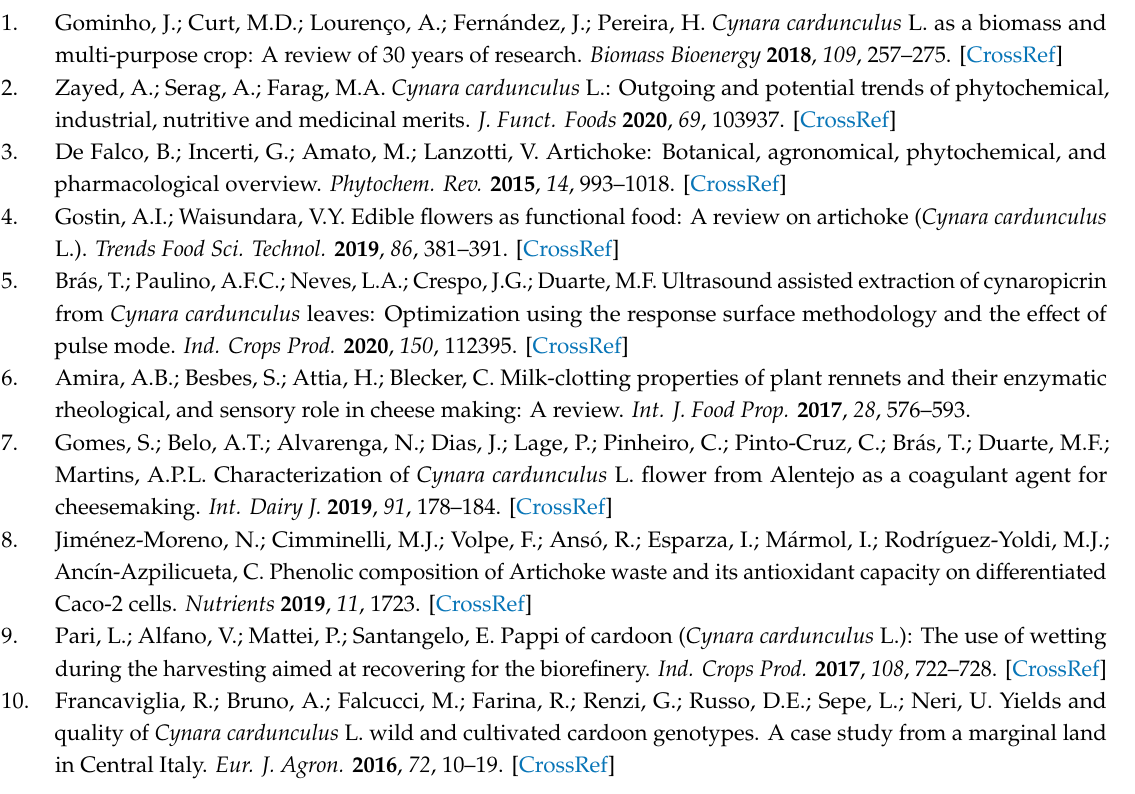
Table S1: Composition of fatty acids (mg / 100 g dw) of Cynara cardunculus heads in relation to maturity 16 stage (mean ± SD; n =